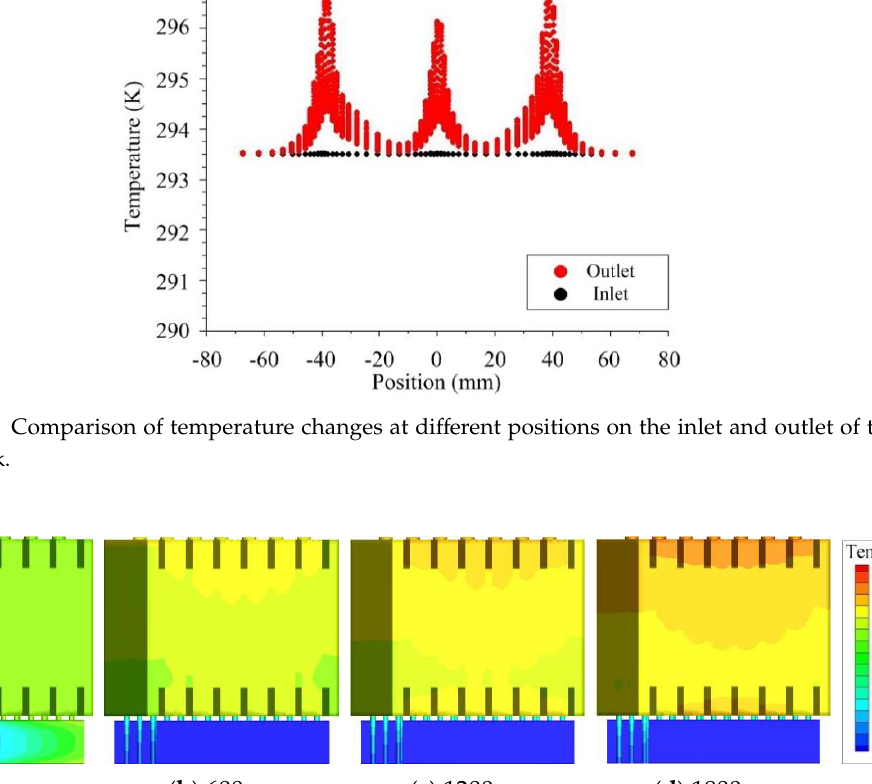
( d ) 1800 s Figure 10. Temperature cloud graphs of battery pack at ambient temperature of 303K. ( a ) 18s ( d ) 1800 s Figure 11. Temperature cloud graphs of battery pack at ambient temperature of 313 K. As shown in the figure, when the ambient temperature is 303 K and 313 K, the temperature of the battery pack, respectively, reaches 313.7 K and 321.2 K at the end of the discharging, which is 8.4 K and 10.3 K lower than that in the natural state, which verifies the effectiveness of CCCS proposed in this paper. Although by adding this system the temperature of battery pack decreases significantly, when the ambient temperature reaches 313 K the temperature of battery pack is still very close to the upper limit of the permitted temperature. 4.4. Simulation with Optimized CCCS When ambient temperature is 313 K, Figure 12 shows a comparison of temperature changes at